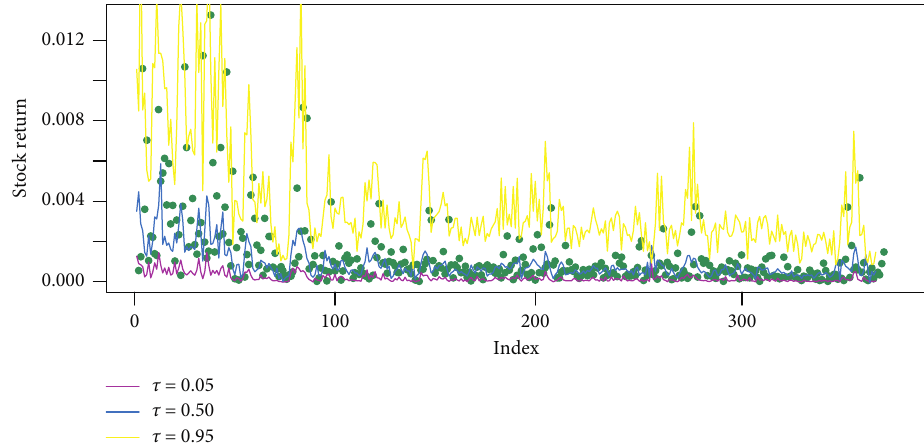
Figure 3: Comparison of fitting effects of different subloci ( τ � 0 . 05 , 0 . 50 , 0 . 95)